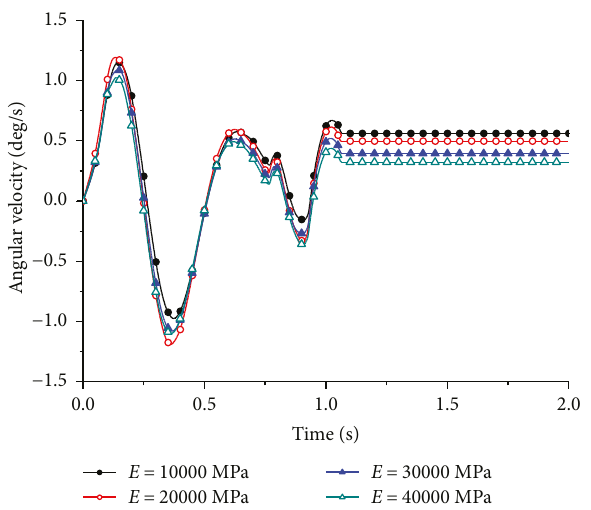
Figure 23: Pitch angular velocity of the missile at di ff erent elastic modulus.